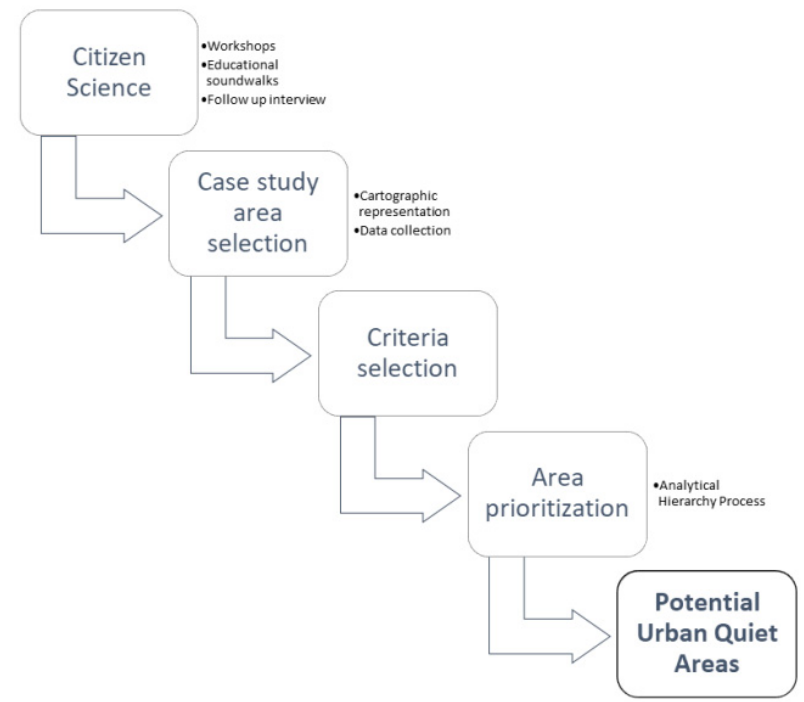
Figure 1. The soundscape approach flow chart.